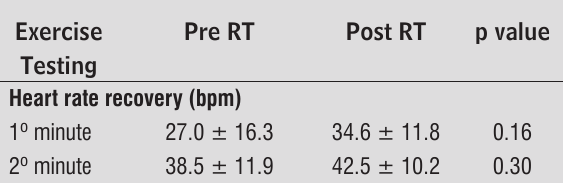
Table 3 - Average values, standard deviation and p value of HRR in exercise testing, developed in 10 patients diagnosed with